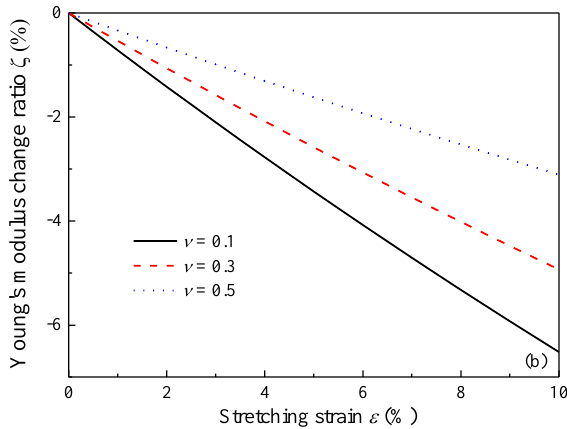
Figure 7. Effect of stretching on Young’s modulus of GPL/Epoxy nanocomposites ( a ) stretching direction; ( b ) transverse direction.